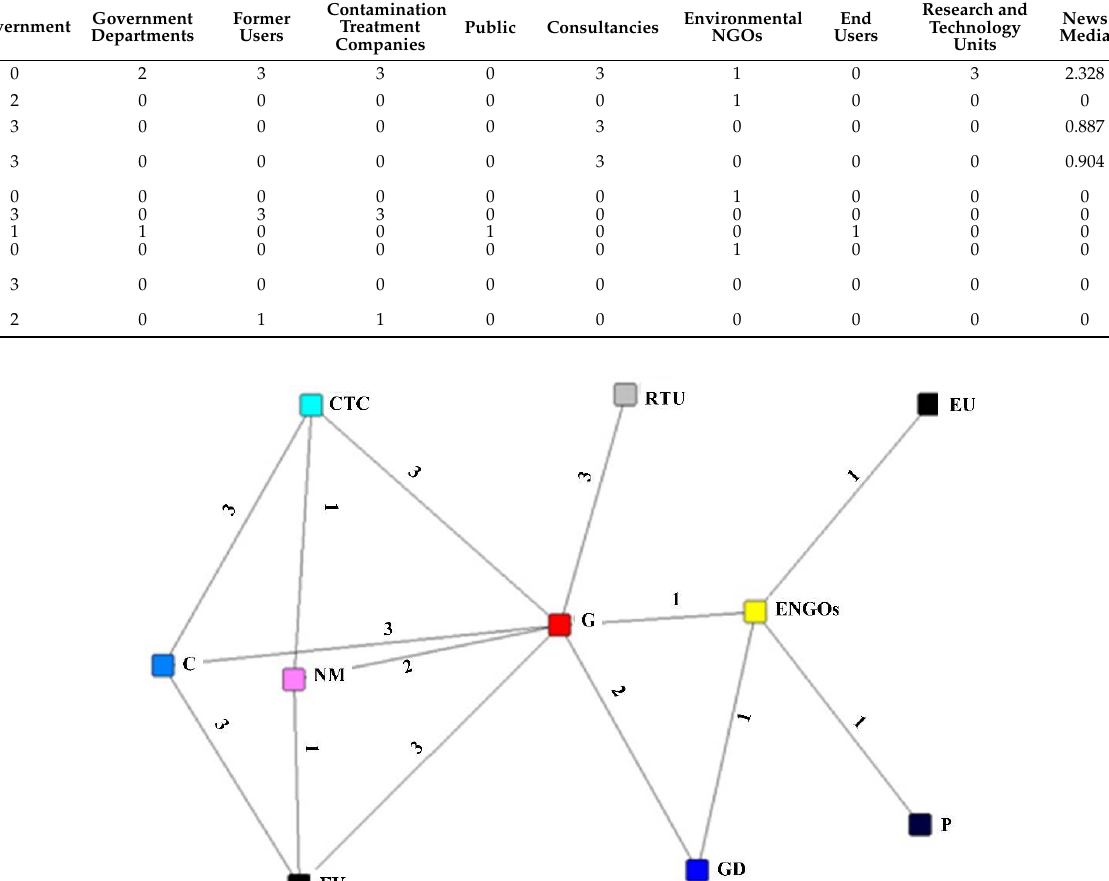
Figure 4. Relationship network of BR stakeholders at the recycling and contamination treatment stage. Table 2. Relationship matrix of BR stakeholders at the recycling and contamination treatment stage.